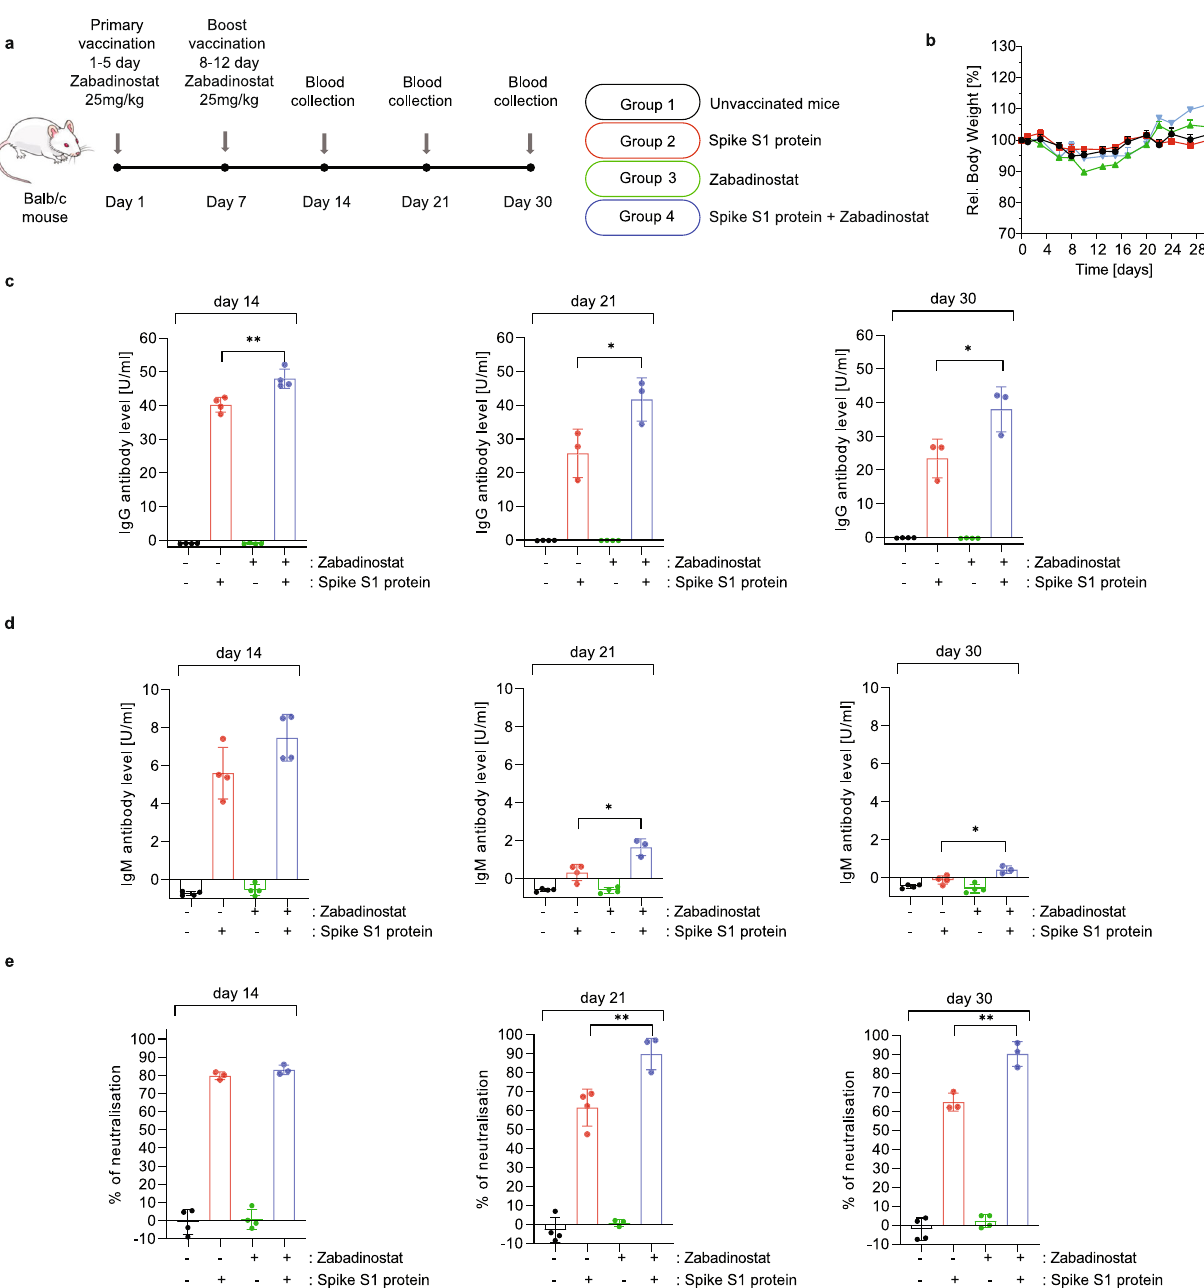
Fig. 6 Zabadinostat enhances the antibody response against the covid19 spike S1 protein. a Schematic representation of the immunogenicity experiment with zabadinostat and spike S1 protein. Balb/c mice were treated with orally administrated zabadinostat at 25 mg/kg for 14 days (5 days on/2 days off) and intravenous spike S1 protein (days 1 and 7) with respect to vehicle-only control. Blood samples were collected on days 14, 21, and 30; n = 4 per group; b Relative body weight representation of treated and non-treated mice; n = 4; results presented as mean values + / − SD; Analysis of IgG ( c ) and IgM ( d ) spike protein antibodies at days 14, 21, and 30 in serum collected from mice treated with spike protein, zabadinostat, the combination and the control group; n = 4; results presented as mean values + / − SD; one-way ANOVA. e Analysis of spike S1-ACE2 neutralising antibodies at days 14, 21, and 30 in serum collected from mice treated with spike protein, zabadinostat, the combination, and the control group; n = 4; results presented as mean values + / − SD; one-way